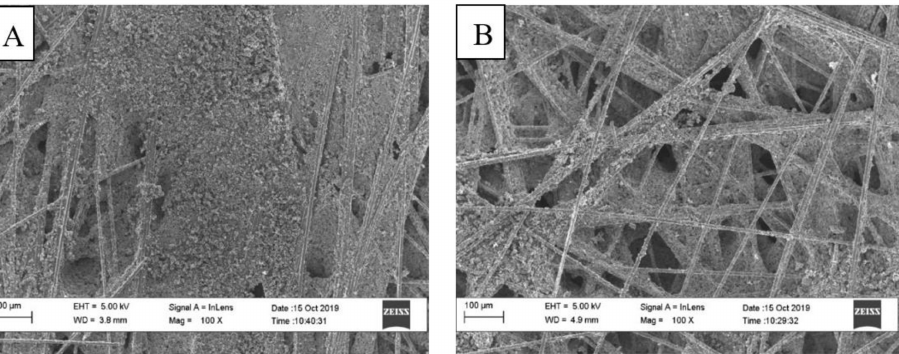
Figure 5. Scanning electron microscopy (SEM) images of ( A ) electrode E4 was calendered and thermally treated at 130 ◦ C for 16 h, and ( B ) electrode E2b, non-calendered and thermally treated at 130 ◦ C for 16 h, shows the difference between calendered and non-calendered